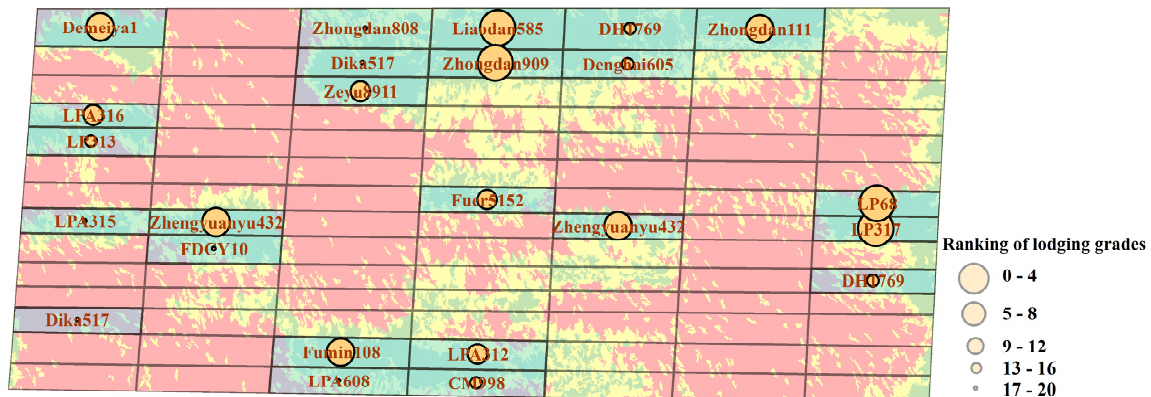
ISPRS Int. J. Geo-Inf. 2021 , 10 , x FOR PEER REVIEW Figure 17. Spatial distribution of the 20 maize varieties most resistant to lodging. In the sowing-date experiment, the aisles or gaps between plots lead to a lodging fraction and degree of lodging that is far less than in the other experimental plots. These plots experienced only a small amount of LL and a small amount of SL. The lodging re- sistance of the three varieties remains essentially the same over the eight sowing dates. The fifth, sixth, and seventh stages are lodging-prone (i.e., R1, VT, and V14; see Figure 18). Figure 19 compares the maize lodging under different nitrogen treatments. The re- sults of nitrogen gradient treatment indicate that increasing the total nitrogen amount im- proves the lodging resistance of maize and decreases the fraction of SL. However, no sig- nificant change occurs in the range of NL.